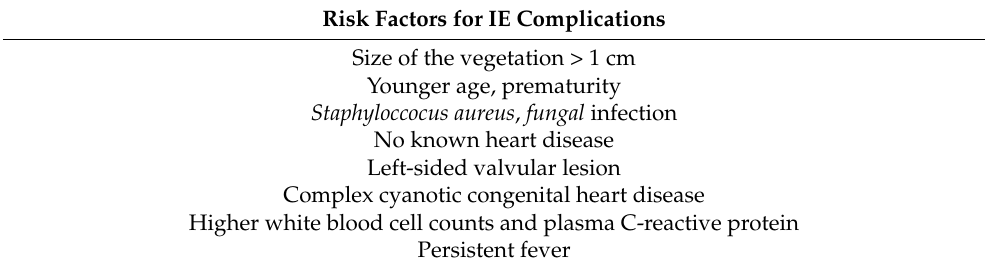
Table 5. Predisposing factors for complications in children with infective endocarditis.